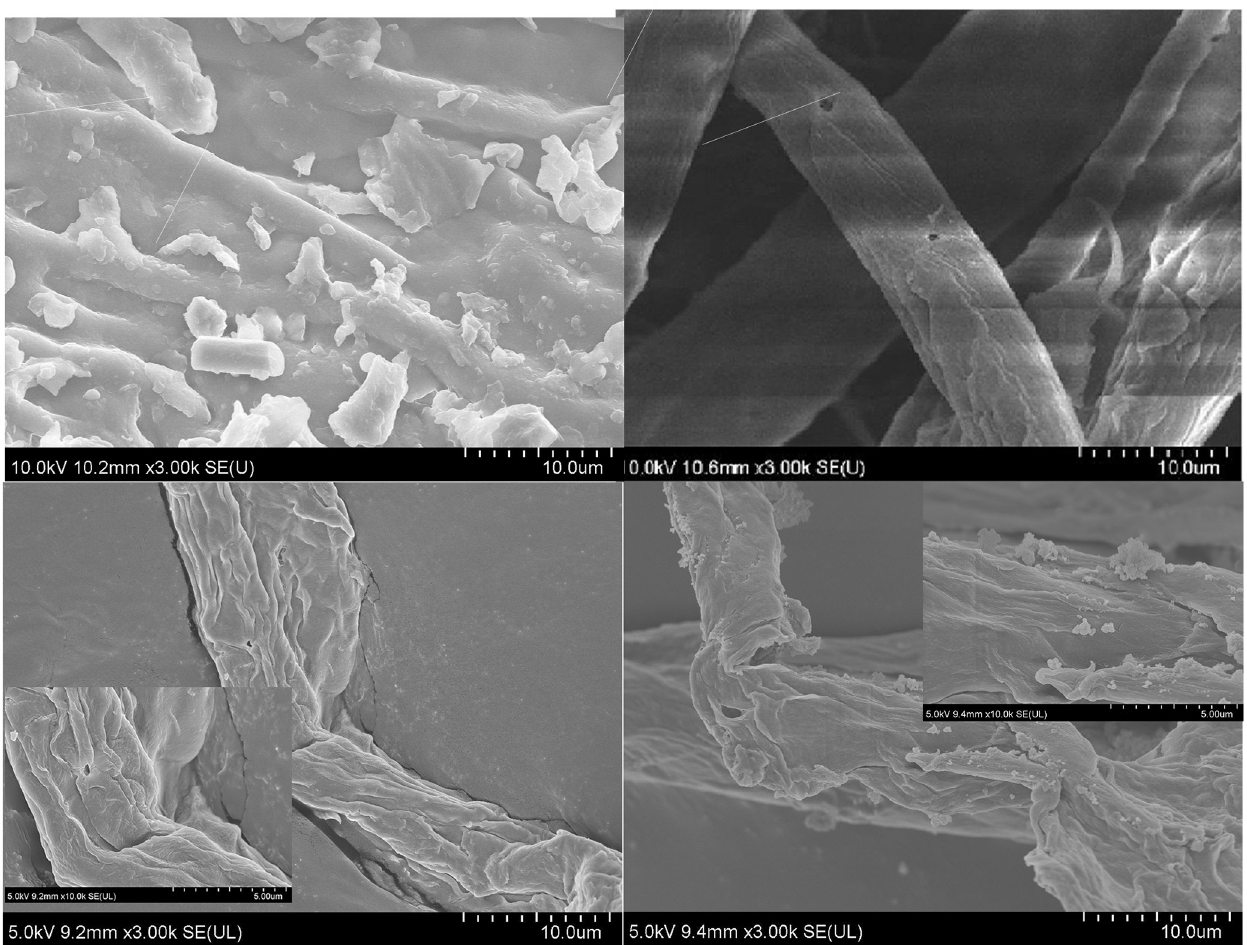
Fig 4. FE-SEM micrographs of (a) Raw PPF, (b) ABT-PPF, (c) AH-C and (d) HPH-CNC.